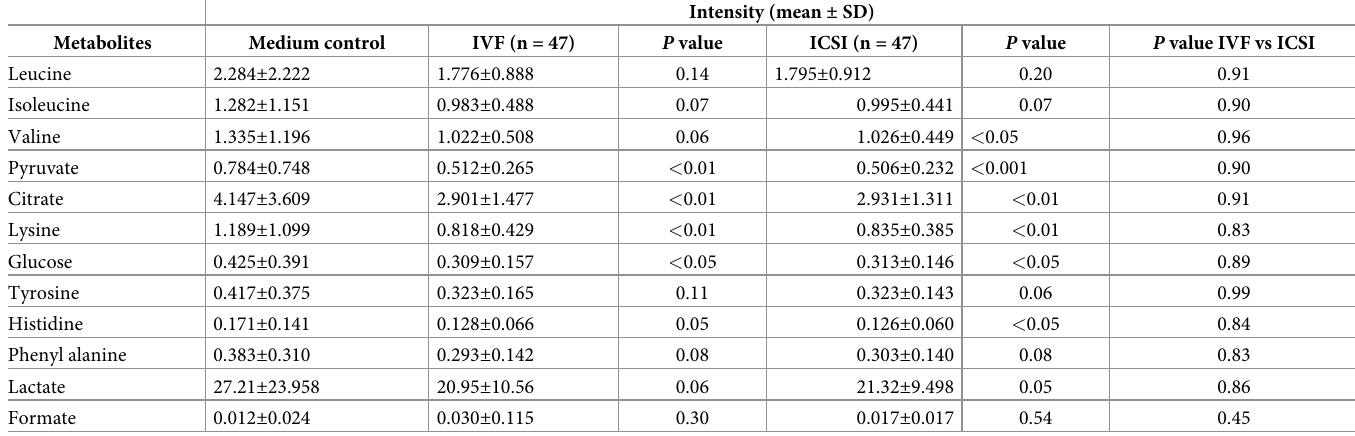
Table 3. Comparison of the relative intensities between IVF and ICSI derived embryo SCM metabolites (normalized to TSP) along with medium control metabo- lites. Data represented in mean ±